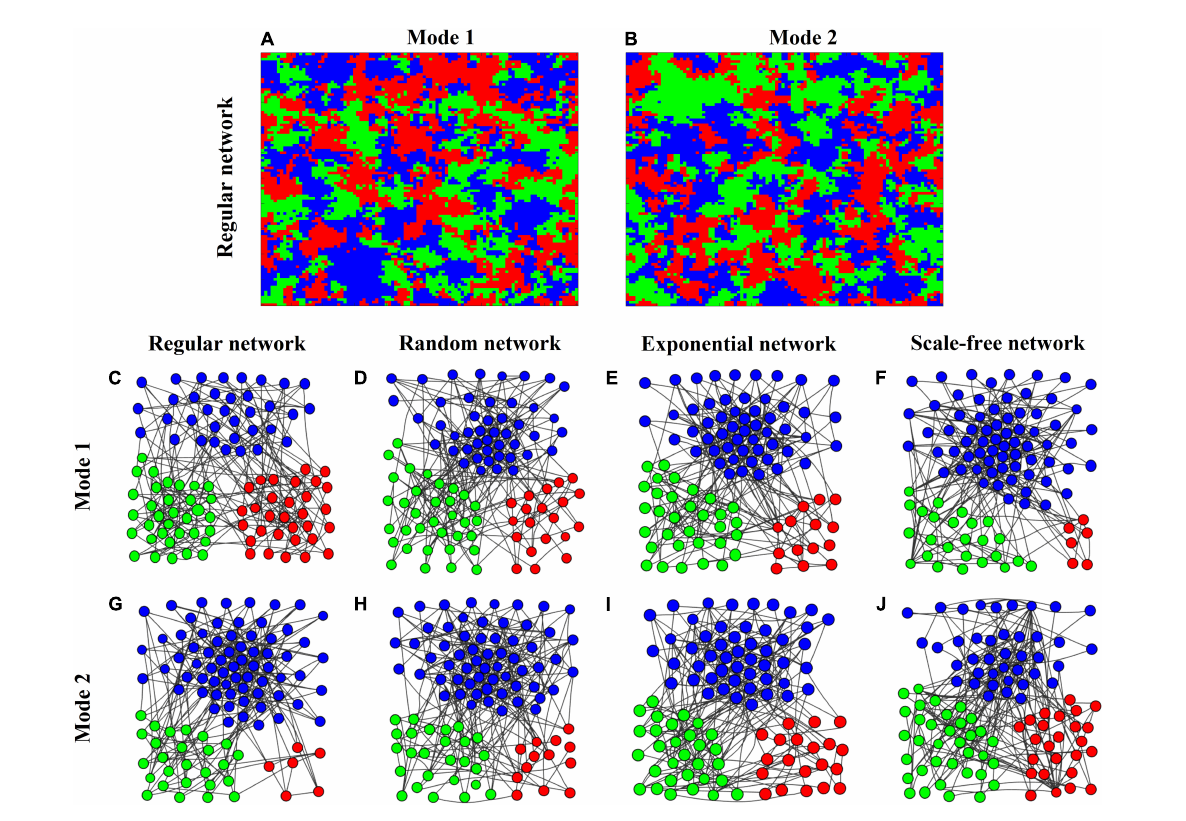
FIGURE4 (A,B) Snapshots of the spatial organization of a 3-species system in rock-paper-scissors games at the 1000th generation in the lattice-structured regular network of size N = 10 4 patches with average degree k 4 under Modes 1 & 2. Individuals of each species are painted in a different color. (C–J) Snapshots of the spatial patterns of the three species under Modes 1 & 2. (C–F) Mode 1 at the 5th generation; (G–J) Mode 2 at the 20th generation) in different networks (lattice-structured regular, randomly connected, exponential, and scale-free) of small size N = 100 patches (with k 4) for clarity.